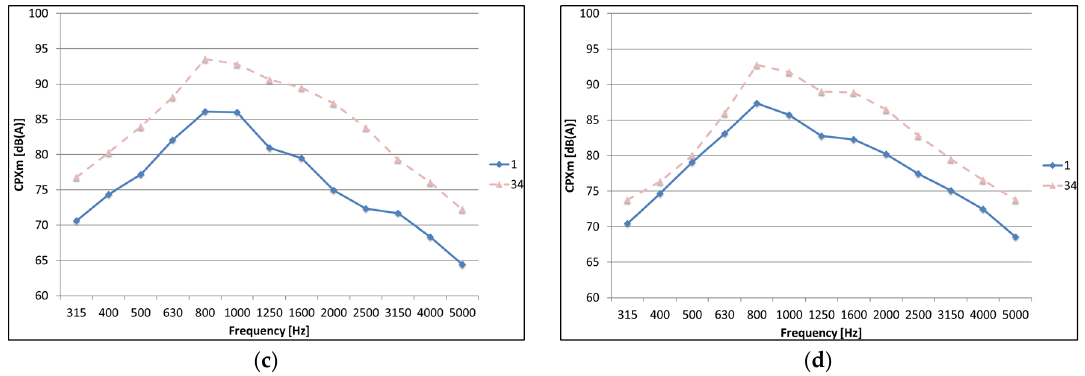
Figure 13. CPX third octave band spectra (P1) one and 34 months after construction: ( a ) SMA ‐ 10;